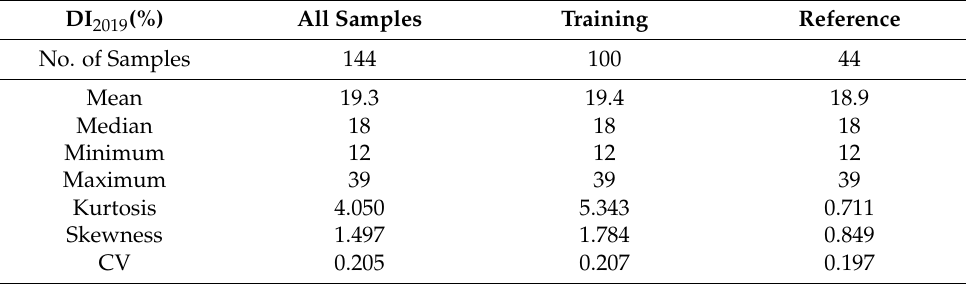
Table 3. Statistical data of training and reference samples for the study area.